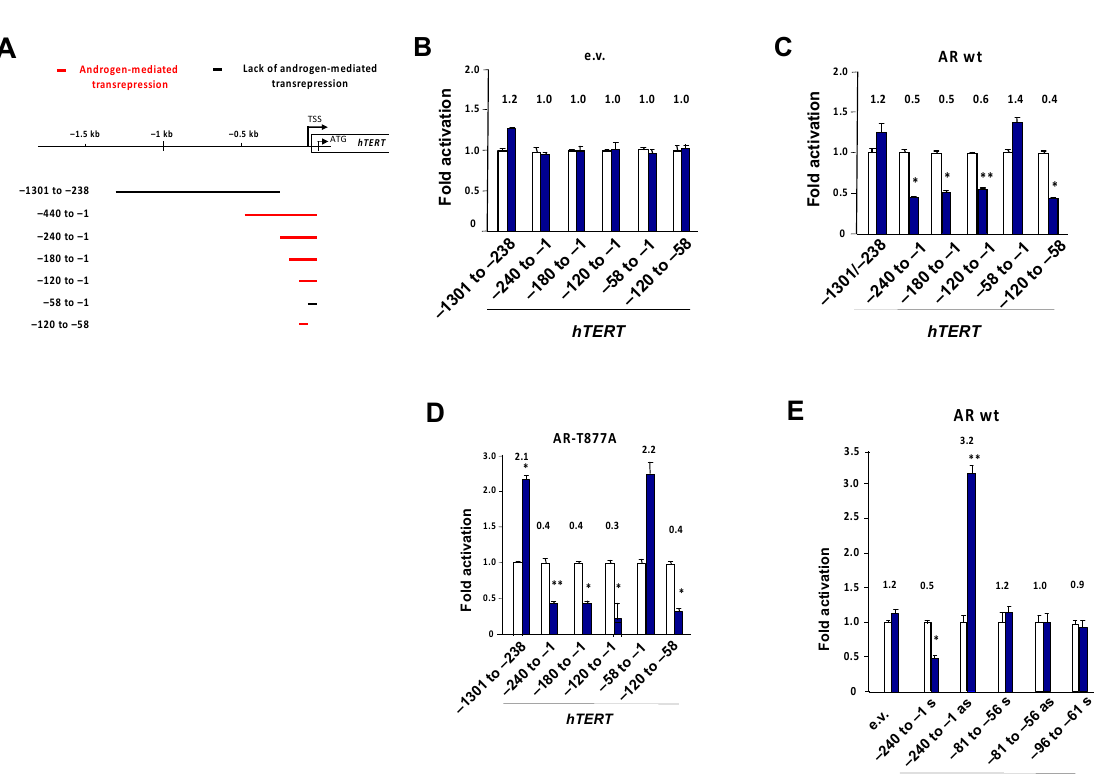
Figure 5. Identification of a negative androgen response element in the hTERT proximal promoter. ( A ) Overview of proximal hTERT deletion constructs for the reporter assays used. The sections highlighted in red are indicative of androgen-mediated repression, whereas the black line does not suggest an androgen-mediated response. ( B – E ) Luciferase assays with indicated hTERT promoter spanning the proximal promoter region constructs in similar experimental setup as in Figure 4. e.v.—empty vector lacking hTERT sequences or ( E ) the cDNA for the receptor ( B ); ARwt—wild-type AR; AR-T877A—mutant AR, R1881 (1 nM). Numbers above the bars indicate the fold induction by androgen treatment. s—sense; as—antisense orientation of the inserted hTERT fragment. * p ≤ 0.05, ** p ≤ 0.01.